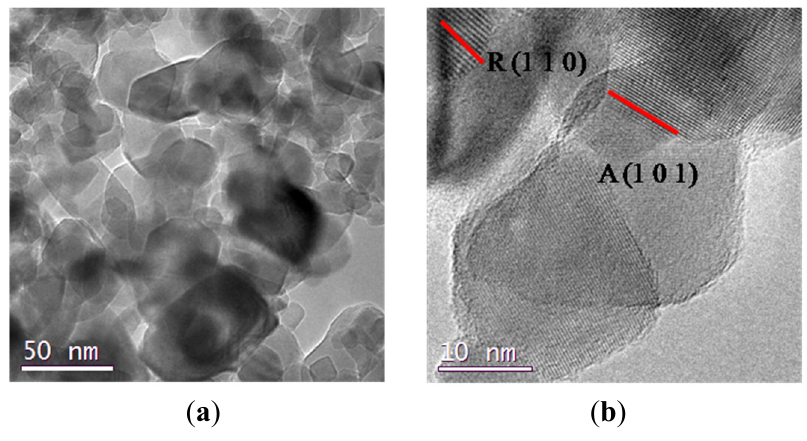
Figure 5. ( a ) TEM images of P25; ( b ) detail at high resolutions for P25.